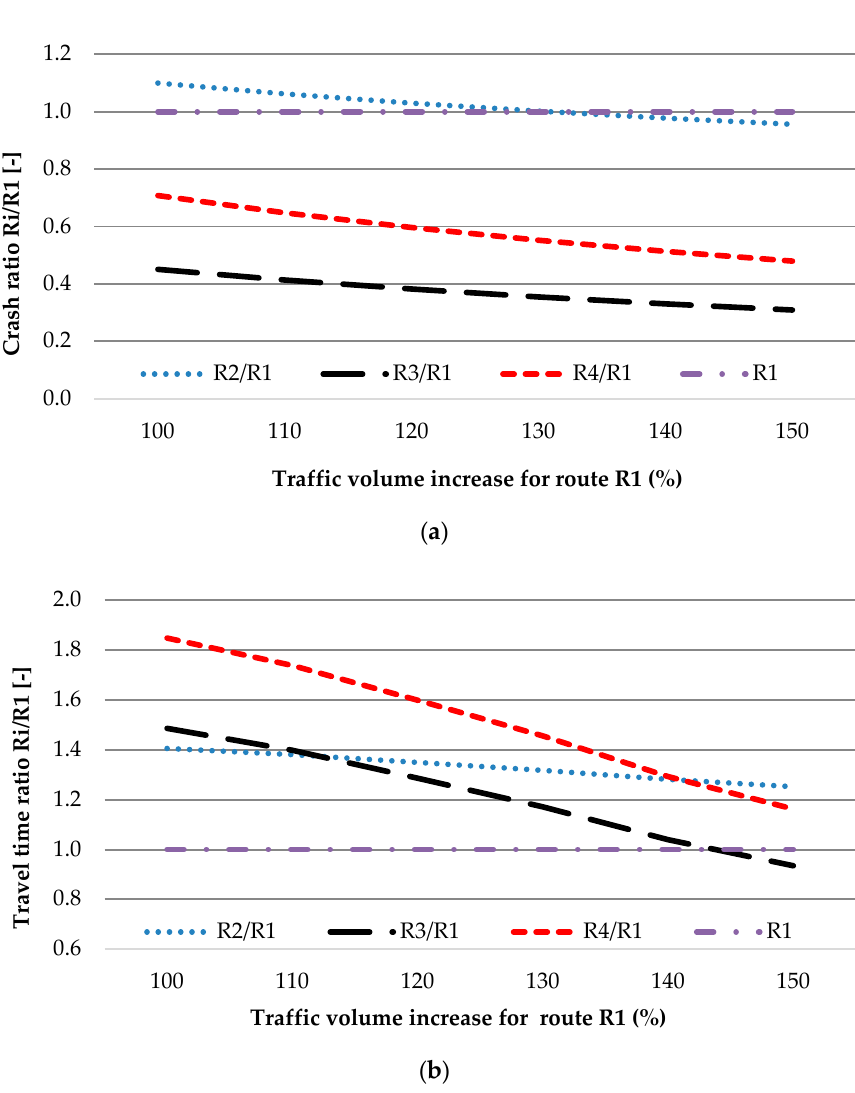
Figure 7. Crash ( a ) and travel time ( b ) ratio for increase in traffic volume only for route R1. Sensors 2020 , 20 , x FOR PEER REVIEW